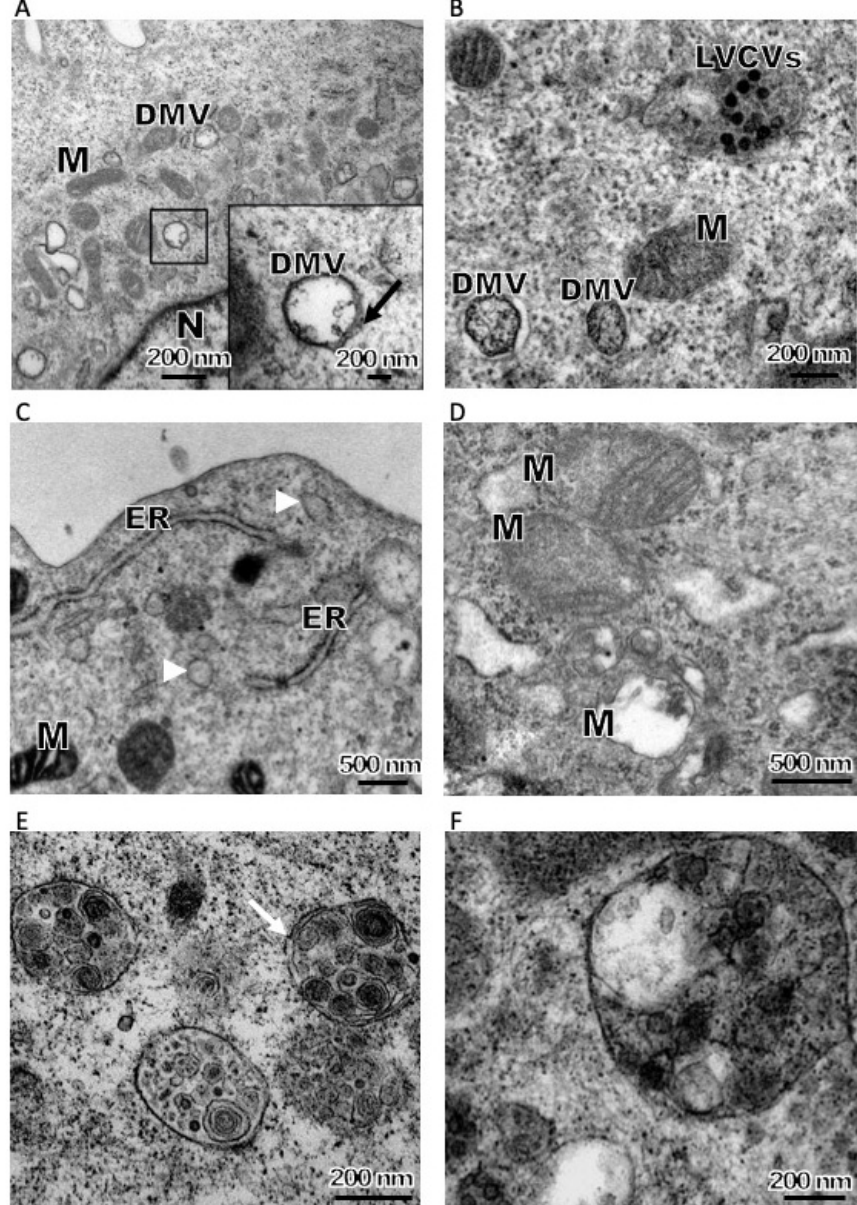
Figure 3. Representative images from EM of PDCoV induces membrane structures. ( A , B ) Double membrane vesicles (DMVs) induced by PDCoV infection. Most of the DMVs, lacking the fibrous material, were separate entities or in small clusters in the cytoplasm, and the inner and outer membranes were generally tightly apposed ( A ). DMVs containing an electron-dense core and luminal spacing between the outer and inner membranes also could be observed (Ainset). DMVs containing an electron-dense core also could be observed ( B ). ( C ) PDCoV infection induces the zippered ER and the ER curved to form a double-membrane vase-like compartment (white arrowhead). ( D ) Upon PDCoV infection, damages of the mitochondria, showing the disappearance of cristae, could be observed. ( E , F ) PDCoV infection induced autophagosome-like compartments in the cytoplasm of infected LLC-PK1 cells. Autophagosome-like vacuoles or lysosomes contain RER, small vesicles, mitochondrion and other vesicles. Double membrane of the vacuoles is partially visible (arrow). ER: endoplasmic reticulum, M: mitochondria, N: nucleus.